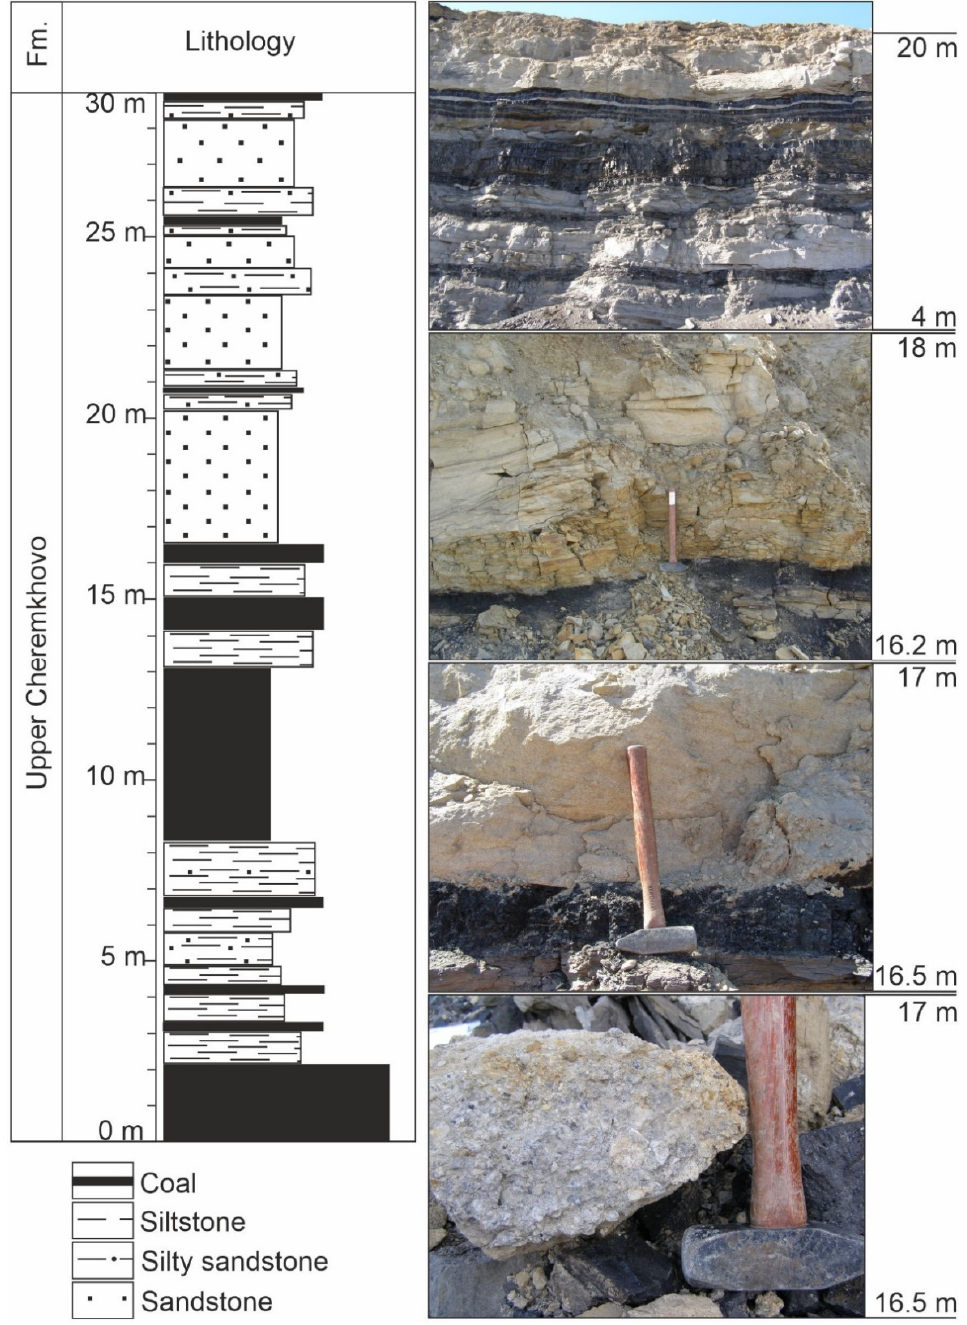
Figure 5. Section of the upper Cheremkhovo Fm. sampling in the area of the Cheremkhovo and Golovinsk coal deposits.